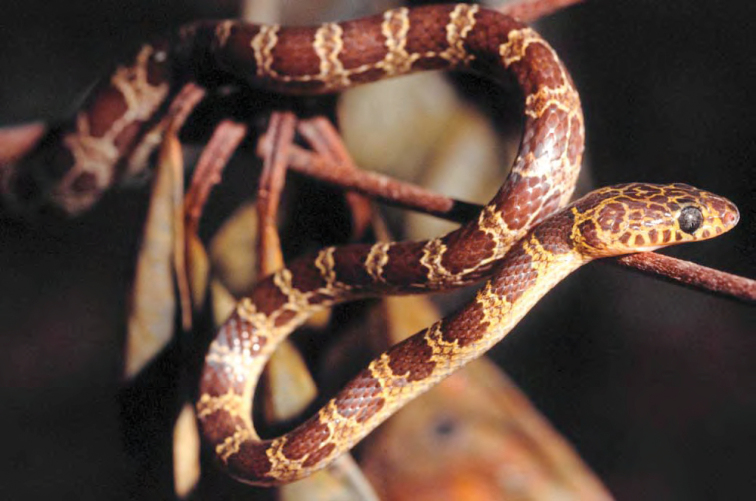
Typical appearanceof Lycodon muelleri (PNM 6592) from Barangay Binatug (Location 22). Photo: ACD.